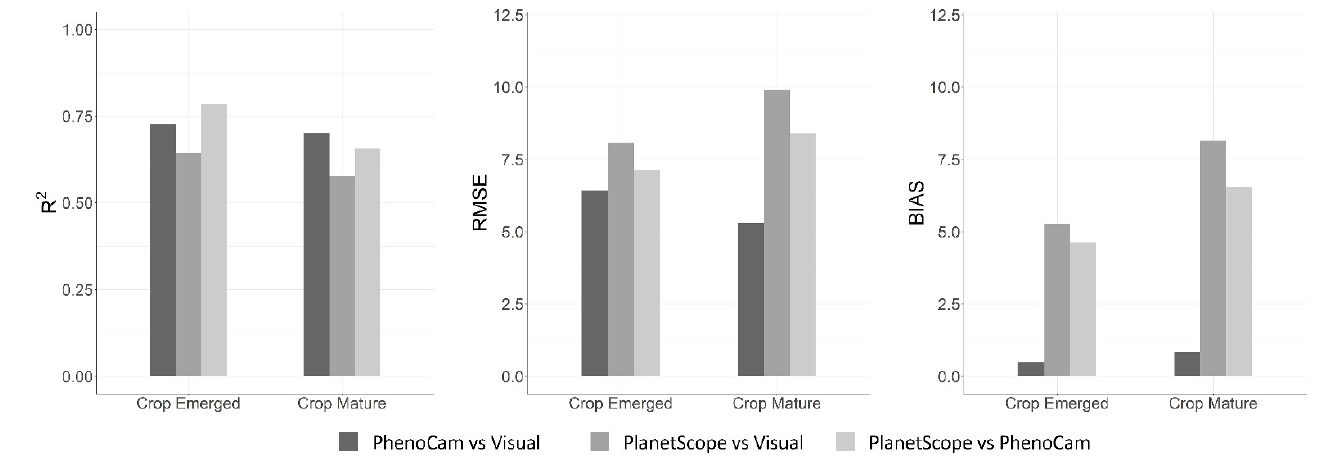
Figure 11. The comparisons among PlanetScope, PhenoCam, and visual phenology with all the shared site-year observations for crop emergence and maturity stages. The CUR-based Greenup metric was estimated for crop emergence and the DER-based EOS metric was estimated for crop maturity. Table 4. The accuracy statistics of comparisons among PlanetScope, PhenoCam, and visual phenol- ogy with all the shared site-year observations using the CUR-based Greenup for crop emergence and DER-based EOS for crop maturity.